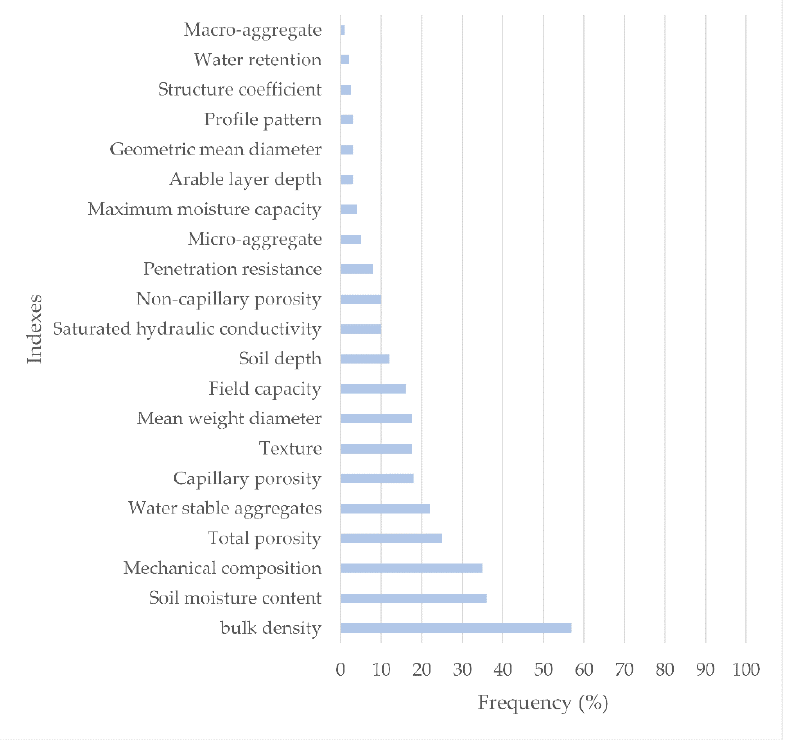
Figure 1. Soil physical evaluation indices.